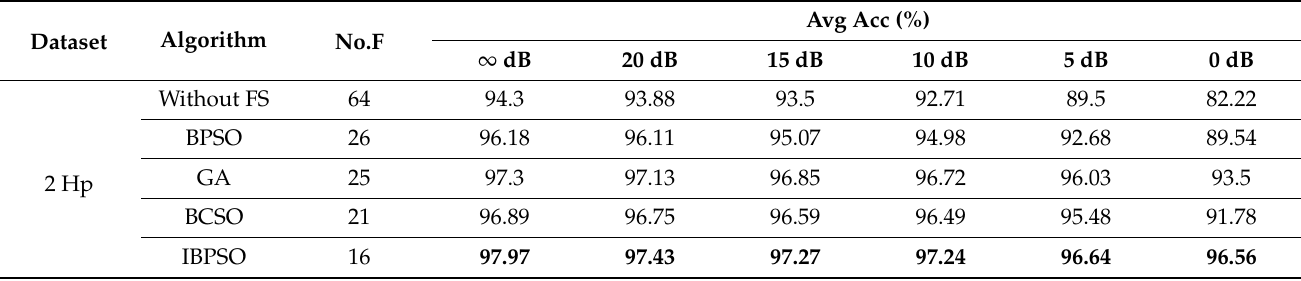
Table 13. Classification results using FCNN-C.